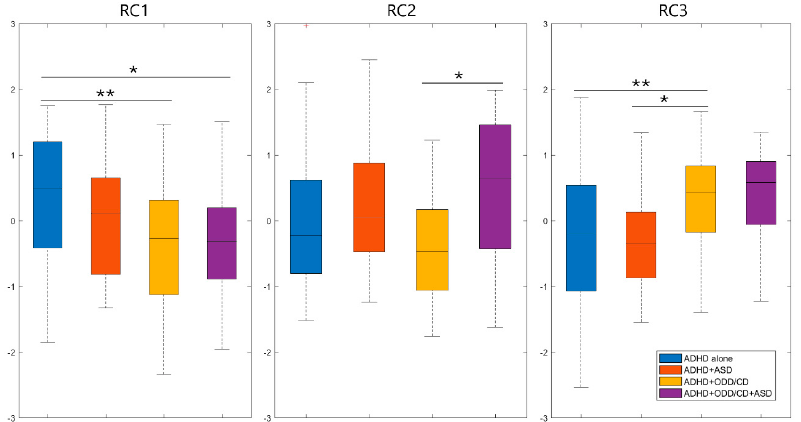
Figure 3. Scores obtained by the four clinical groups in the three components of the principal component analysis, as described in detail in the main text, are illustrated here: ( left ) RC1, ( middle ) RC2, and ( right ) RC3 are compared between ADHD alone group (blue bars), ADHD+ASD group (red bars), ADHD+ODD/CD group (yellow bars), and ADHD+ASD+ODD/CD group (purple bars). Boxplots represent medians and first and third quartiles with minimum/maximum bars. * p -values < 0.05, ** p -values < 0.01. Abbreviations: RC1 = first rotated component; RC2 = second rotated component; RC3 = third rotated component.